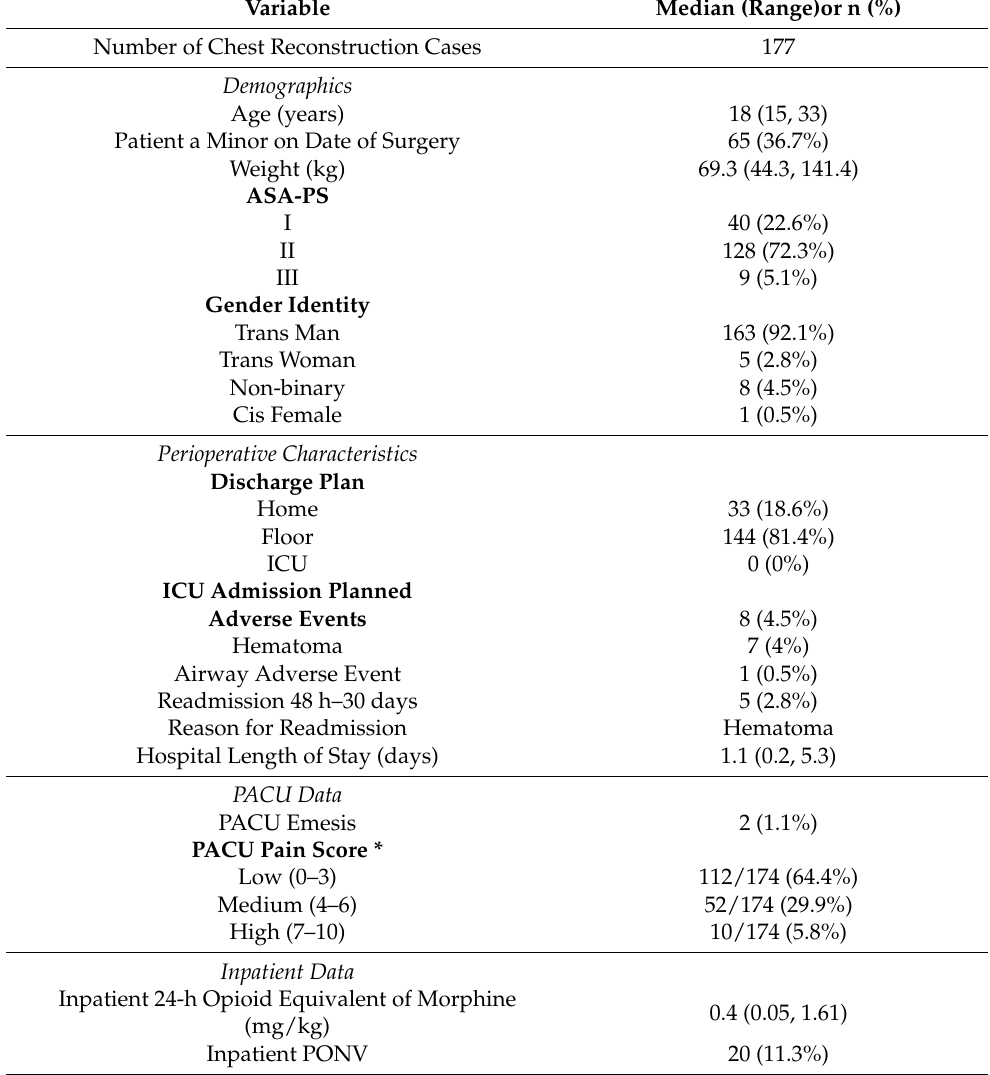
Table 2. Chest Surgeries in the Three-Year Case Series at the Center for Gender Surgery